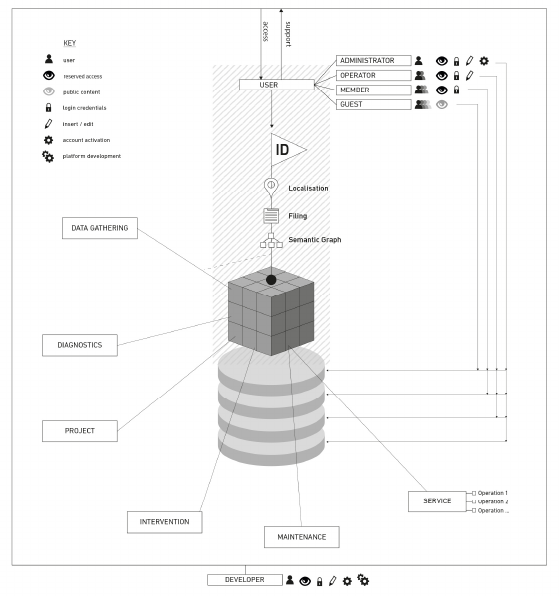
Figure 1. Design of the integrated data management Information System for SACHER 3D